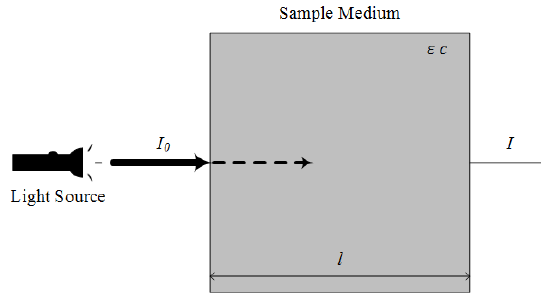
Figure 1. Model of Beer-Lambert’s Law [18].